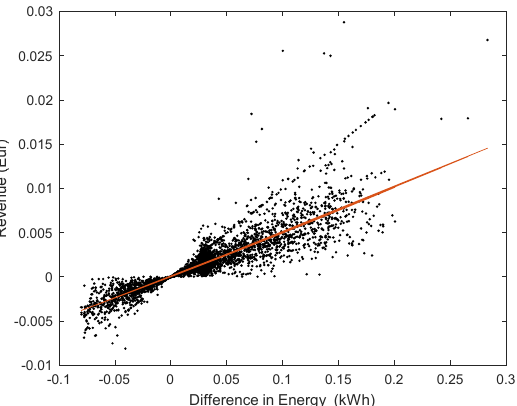
Figure 11. Revenue of the DSPI inverter versus the difference in energy transferred to the electricity network (the red line is a trend line of dispersed data).